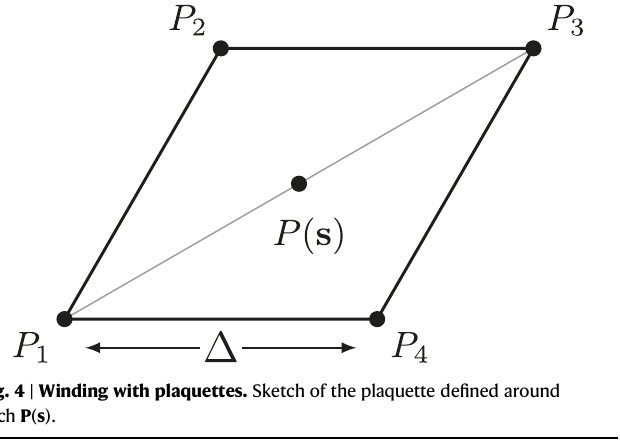
Fig. 4 | Winding with plaquettes. Sketch of the plaquette de fi ned around each P ( s